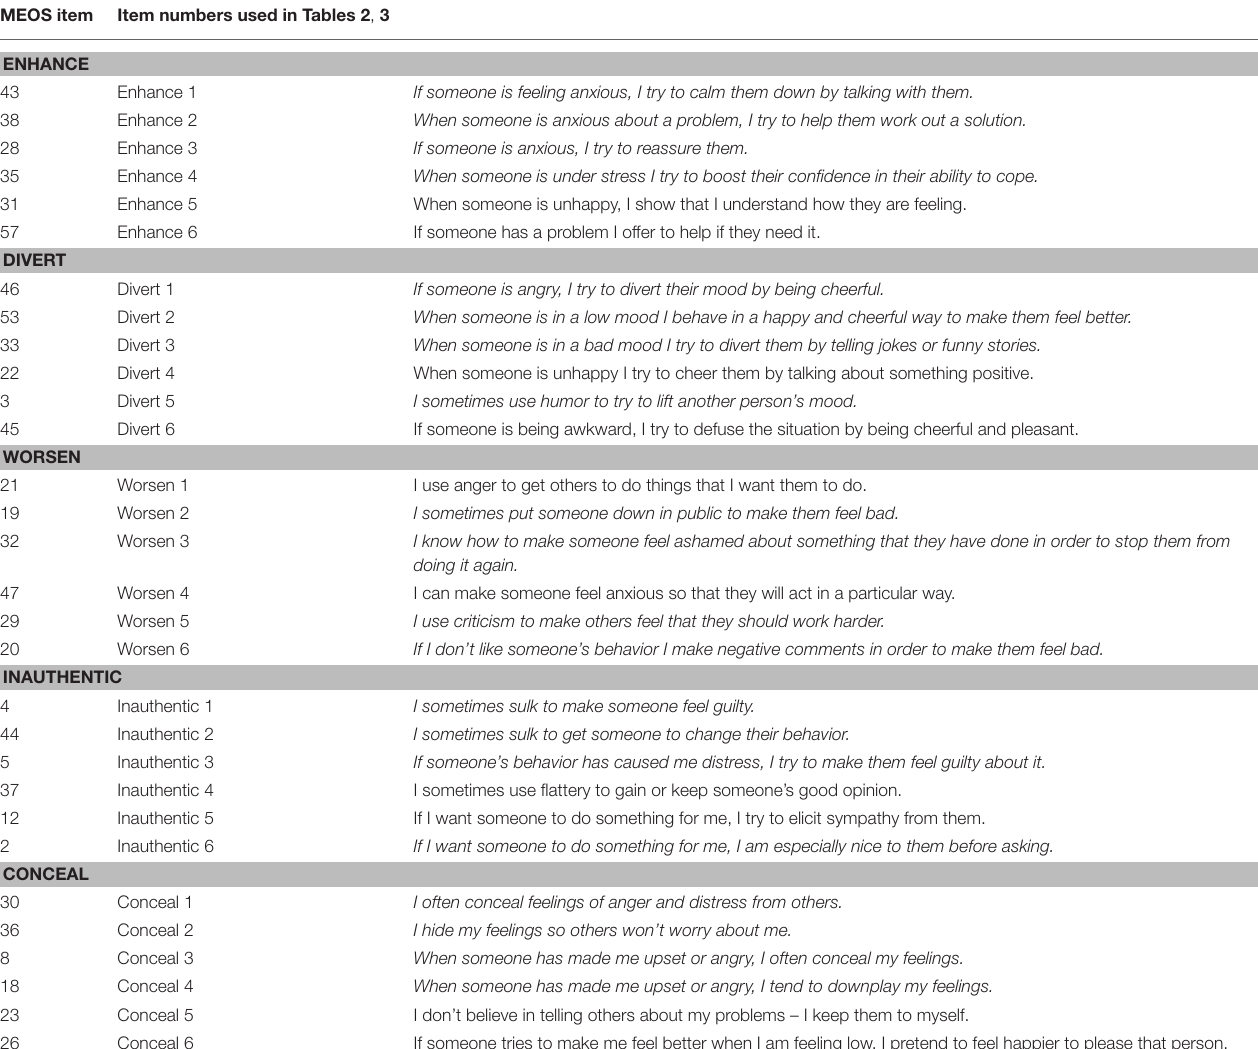
TABLE 5 | Items selected for the MEOS-SF and MEOS-VSF. MEOS item Item numbers used in Tables 2 , 3